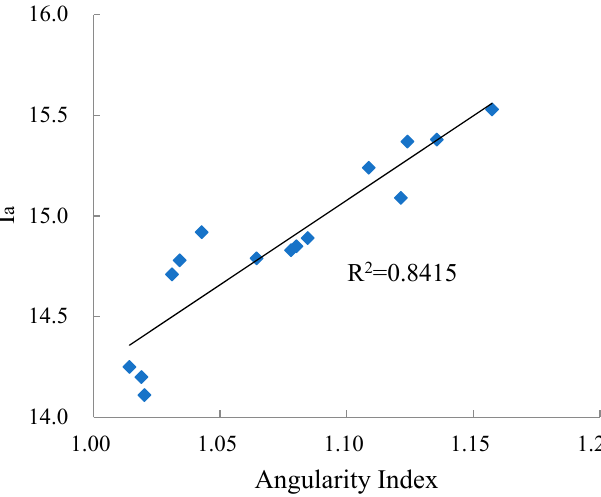
Figure 9. Correlation between aggregate angularity index and Ia.